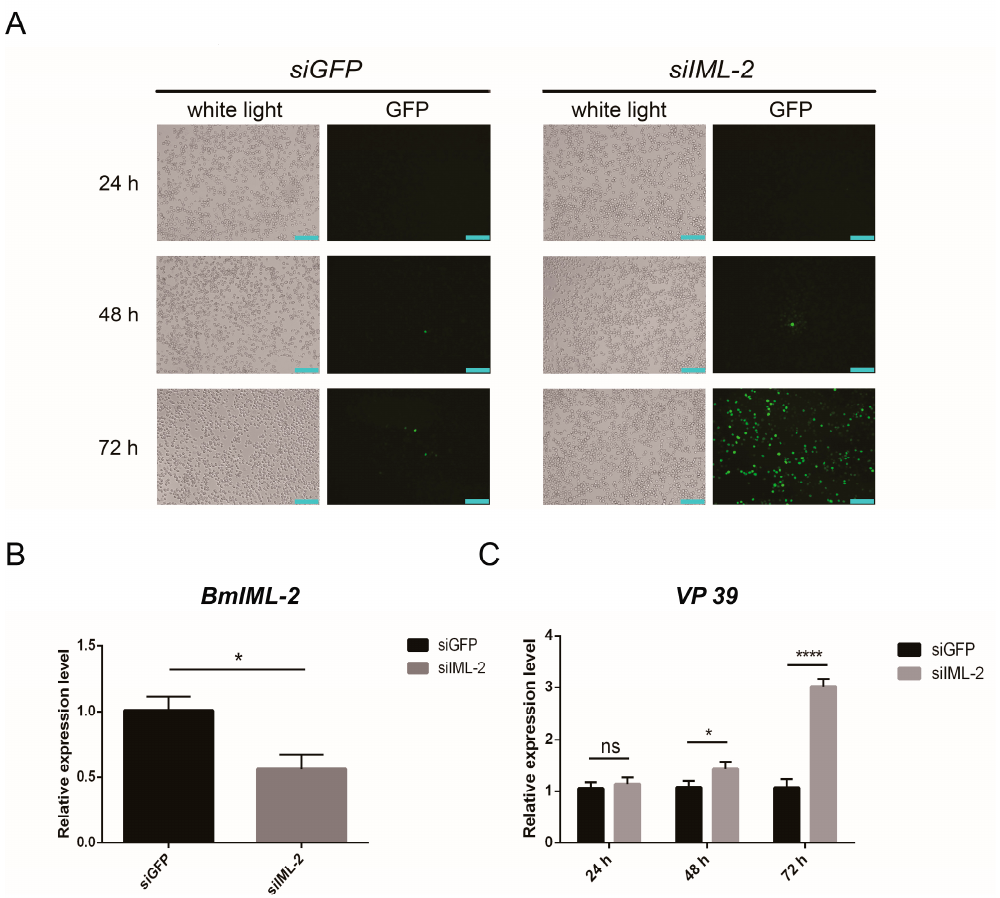
Figure 5. Effects of BmNPV infection and replication by knockdown of BmIML-2 in BmN cells. ( A ) The infected cells after knockdown of BmIML-2 were observed under a fluorescence microscope. White light, optical transmission; GFP, green ; mCherry, red ; scale bar = 200 µ m. ( B ) Transcript level analysis of BmIML-2 at 48 h after transfection of siRNA. ( C ) Transcript level analysis of VP 39 after knockdown of BmIML-2 at different times. Data were calibrated by using BmGAPDH and presented as means ± S.D. of three separate experiments. Asterisks represent significant differences compared the control (unpaired t -test; *, p < 0.05; ****, p < 0.0001; ns, not